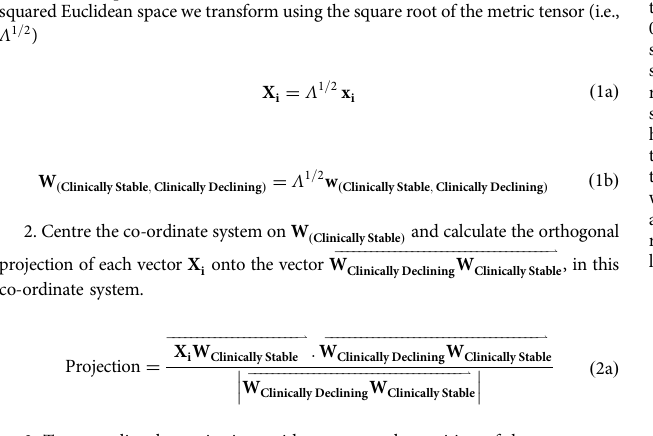
(cid:2)(cid:2)(cid:2)(cid:2)(cid:2)(cid:2)(cid:2)(cid:2)(cid:2)(cid:2)(cid:2)(cid:2)(cid:2)(cid:2)(cid:2)(cid:2)(cid:2)(cid:2)(cid:2)(cid:2)(cid:2)(cid:2)(cid:2)(cid:2)(cid:2)(cid:2)(cid:2)(cid:2)(cid:2)(cid:2)(cid:2)(cid:2)(cid:2)(cid:2)(cid:2)(cid:2) * , in this